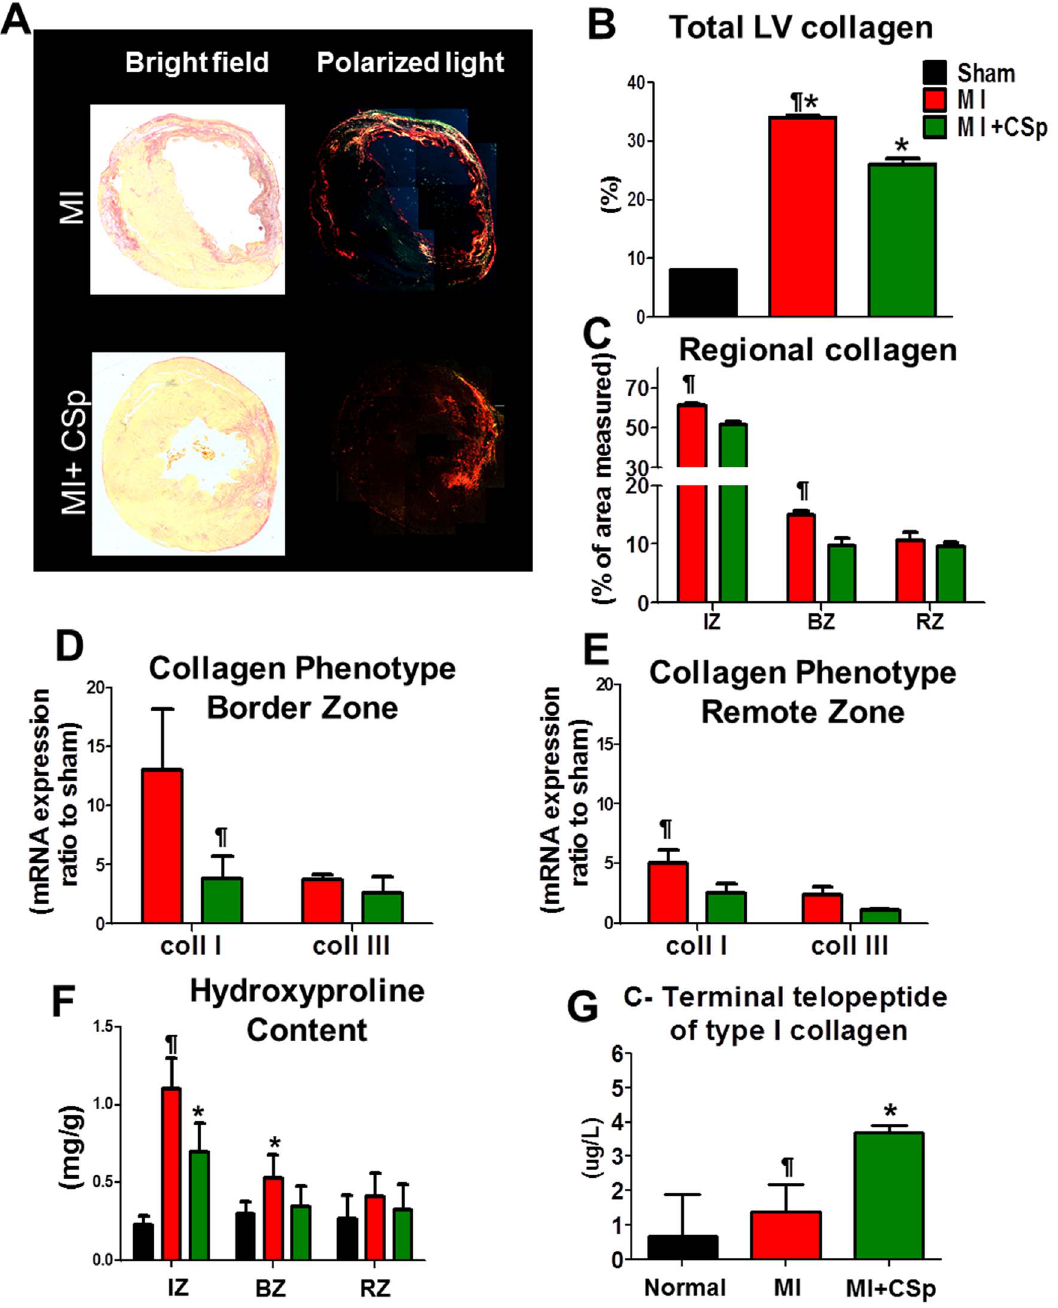
Figure 6. Collagen quantification. (A) Collagen deposition was detected by picrosirius red staining in tissue sections 21 days post MI and CSp transplantation. Representative tissue images under bright field on the left and under polarized light microscope on the right. (B) Quantification of the collagen in the total LV area and C. separately in the infarct, border and remote zone. (D,E) Results of RT-PCR for mRNA expression of coll1a1 and coll3a1 respectively. (F) Hydroxyproline assay performed for collagen content production in the infarct, border, and in the remote zone. Significant differences between the two groups were observed in the infarct and in the border areas. (G) ICTP quantification in the serum collected 7 days post MI and treatment with increased levels detected in the treated group. Abbreviations. IZ (infarct zone), BZ (border zone), RZ (remote zone). Data are mean 6 SEM. " p , 0.05 control vs. MI + CSp, * p , 0.05 vs. sham.